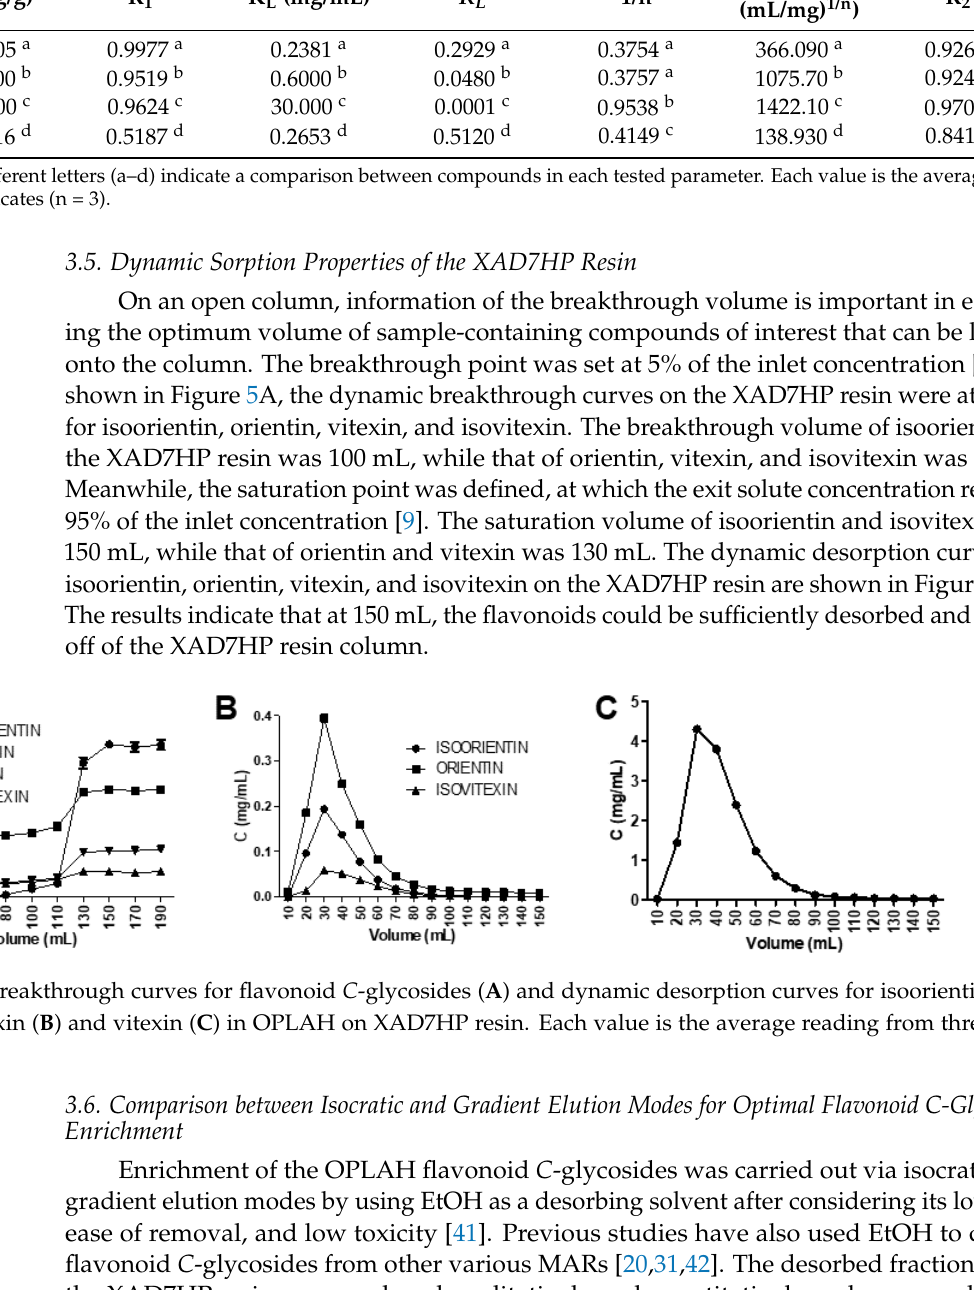
Table 3. Langmuir and Freundlich models for the adsorption of OPLAH flavonoid C -glycosides on XAD7HP resin. Compound